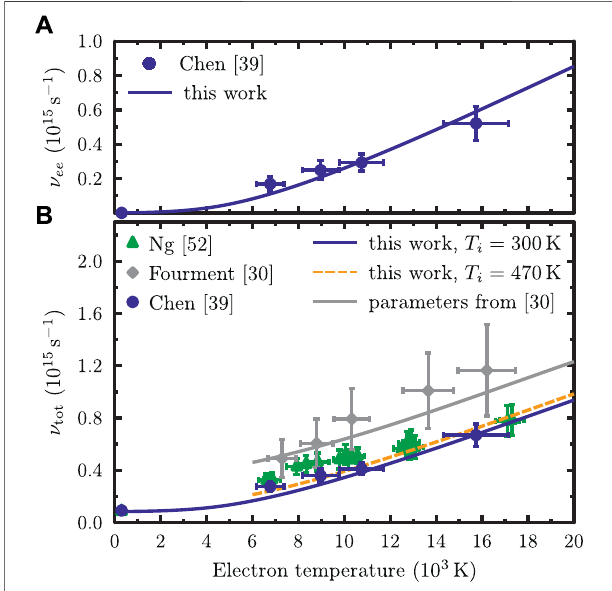
FIGURE 3 | (A) Calculated temperature-dependent electron-electron scattering frequency in gold (blue line) compared with experimental data from Ref. [39] (blue circles). (B) Total scattering rate according to Eq. 8 for a cold lattice (blue solid line) and at a phonon temperature of 470 K (orange dashed line). Calculations are compared with different sets of experimental data obtained from Ref. [52] (green triangles), Ref. [39] (blue circle) and Ref. [30] (gray diamonds),